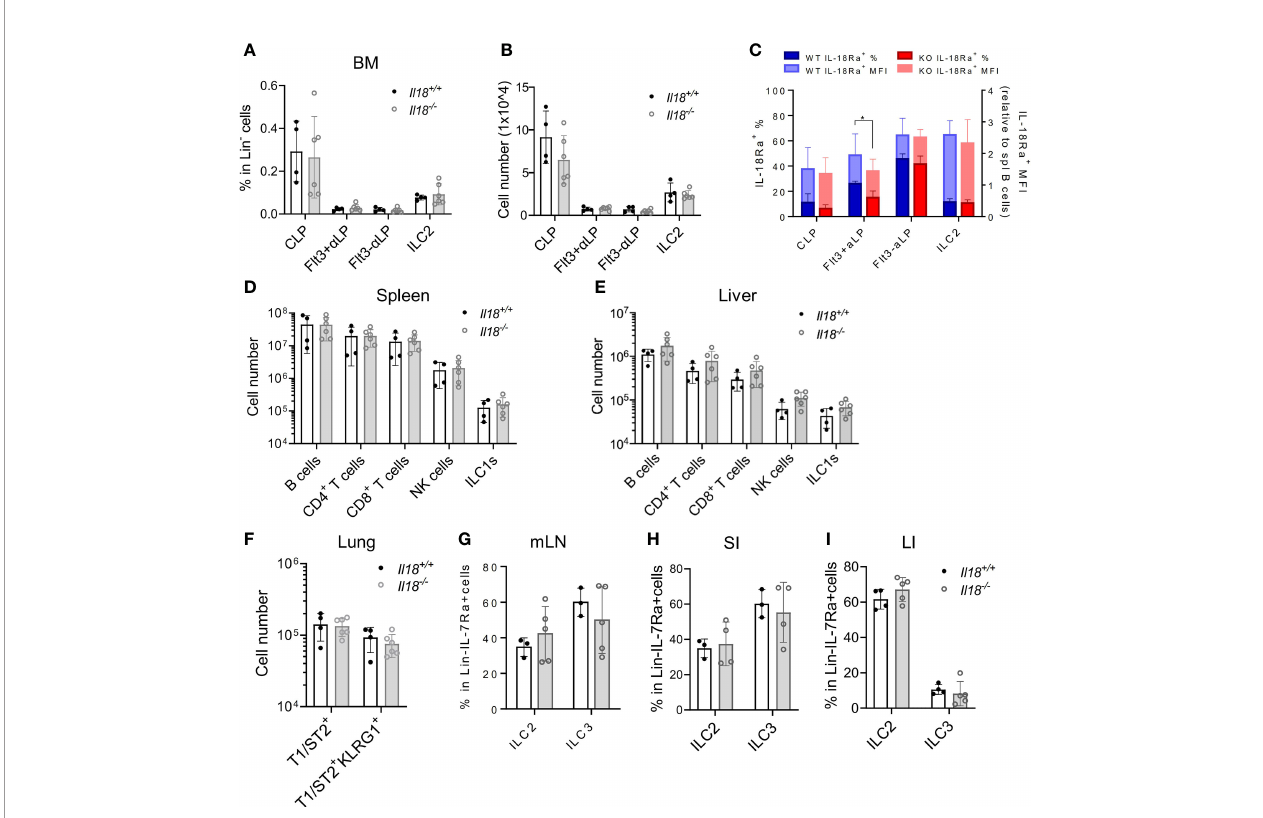
FIGURE 5 | IL18 is dispensable for the generation of IL18Ra + progenitors. (A, B) Percentage and numbers of BM progenitors and ILC2 in Il18 +/+ and Il18 -/- mice. (C) Percentage of IL-18R a + cells in each population from panel A (presented in dark blue and dark red, respectively) and mean fl uorescence intensity of IL-18R a (presented in light blue and light red, respectively) in Il18 +/+ and Il18 -/- mice. (D, E) Numbers of B cells, CD4 + T cells, CD8 + T cells, NK cells, and ILC1 cells in spleen and liver of Il18 +/+ and Il18 -/- mice. (F) Number of total T1ST2 + ILC2 and activated T1ST2 + KLRG1 + ILC2 in the lung of Il18 +/+ and Il18 -/- mice. (G – I) Percentage of ILC2 and ILC3 in mesenteric lymph nodes, small intestine, and large intestine of Il18 +/+ and Il18 -/- mice. Data are representative of three or more independent experiments with three or more mice in each group. The data are presented as mean ±